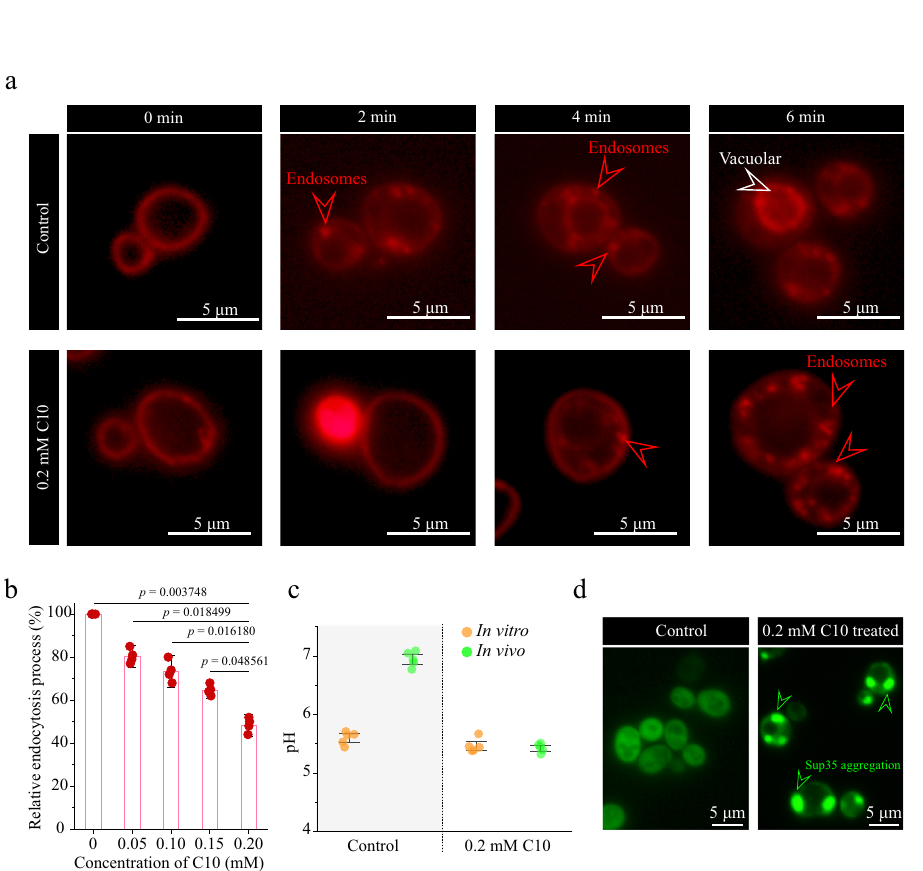
Fig. 1 n-Butanol decrease budding index of S. cerevisiae . a The cell morphology change was detected by microscope and the cells were stained by calco fl uor white (CFW). Additionally, fi eld emission scanning electron microscopy (FESEM) was applied to con fi rm the morphology change under 0.8% (v/v) n-butanol treatment. The white arrows point to the elongated cells. b The time-lapse microscopy of a yeast cell that undergoing the budding process in the control and n-butanol treated group. The yeast cells were acquired at 20 min intervals. Time is indicated in minutes. c Cell length was detected by the microscope, and 120 cells were analyzed both in the control and n-butanol treated group. P values are from a Student ’ s two-sided t -test of the difference from the untreated control group. Values are shown as mean ± S.D. from 120 ( n = 120) cells over three independent biological replicates. d The budding indexes of the control and n-butanol treated group was measured by FACS. The bud neck protein Cdc10 was used as an indicator that visualized the budding process of S. cerevisiae . Here, the fusion protein Cdc10-GFP was introduced into S. cerevisiae , and the GFP signal was just appearing at cells that were under budding process. The high GFP ratio indicates a higher budding index. The green arrows point to the bud necks. Values and error bars represent the mean values and standard deviations of biological repeats. Abbreviations: FACS Fluorescence-activated cell sorting; GFP green fl uorescent protein; CFW calco fl uor white; FESEM fi eld emission scanning electron microscopy. a , b , d Three experiments ( n = 3) were repeated independently with similar results. Source data are provided as a Source Data fi le.